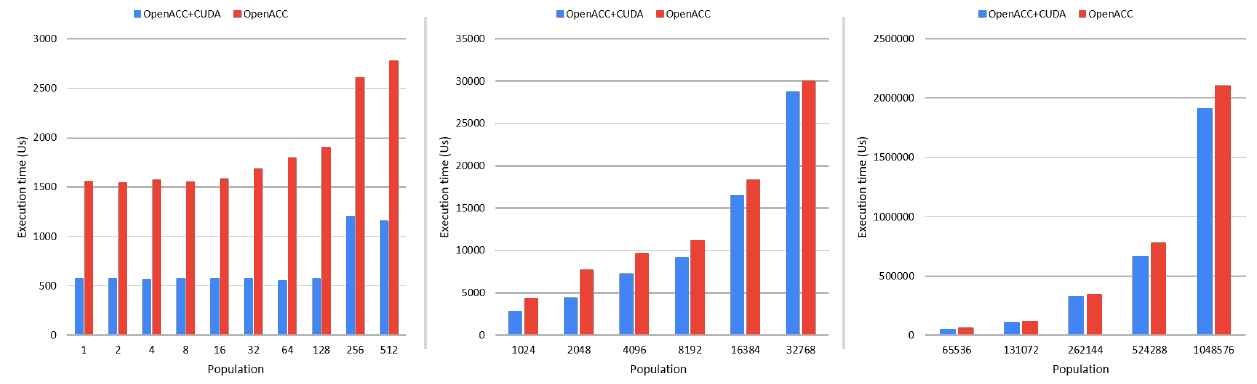
Figure 4. Execution time ( µ s) increasing the size of the population and keeping the number of iterations (100)